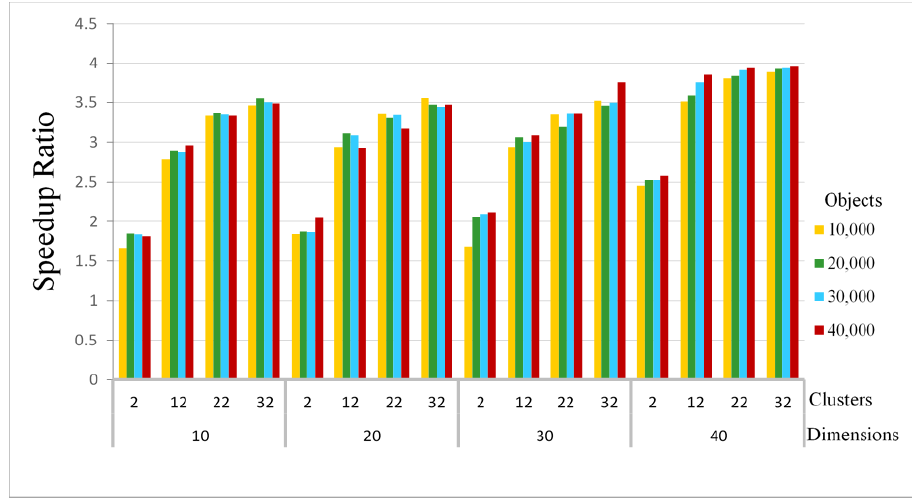
Figure 2. Speedup of Experiment I.